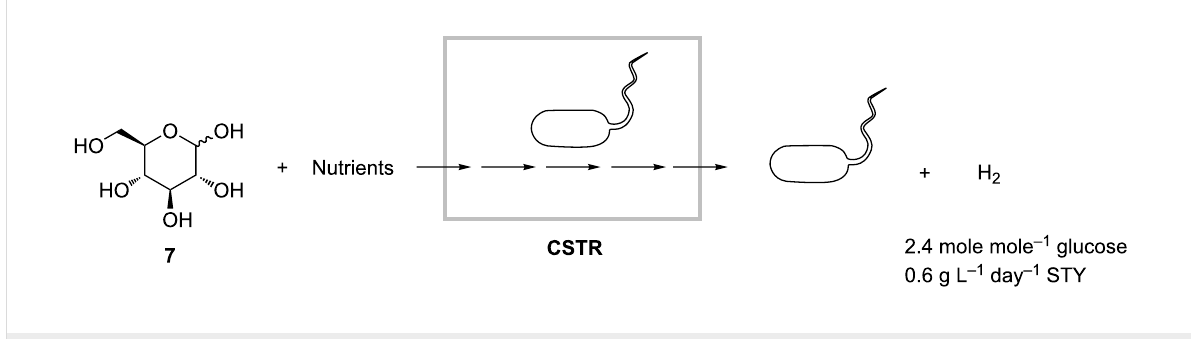
Microbial biotransformations were also successfully